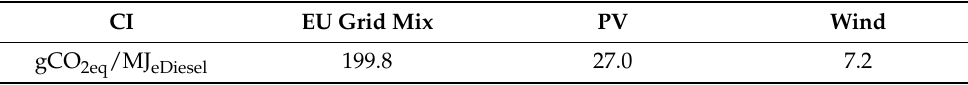
Table 5. Carbon intensity of eDiesel. CI EU Grid Mix PV Wind gCO 2eq /MJ eDiesel 199.8